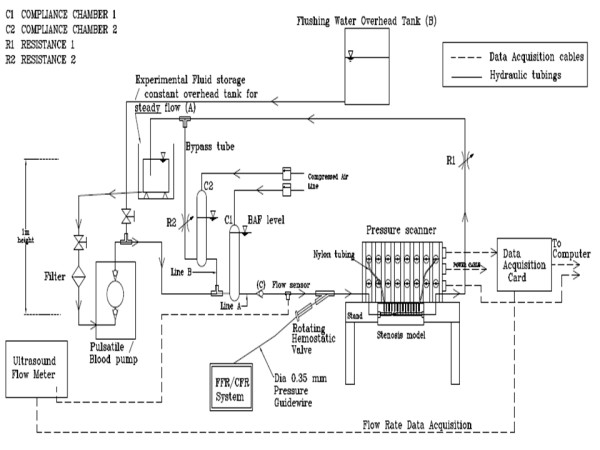
Experimental set-up.